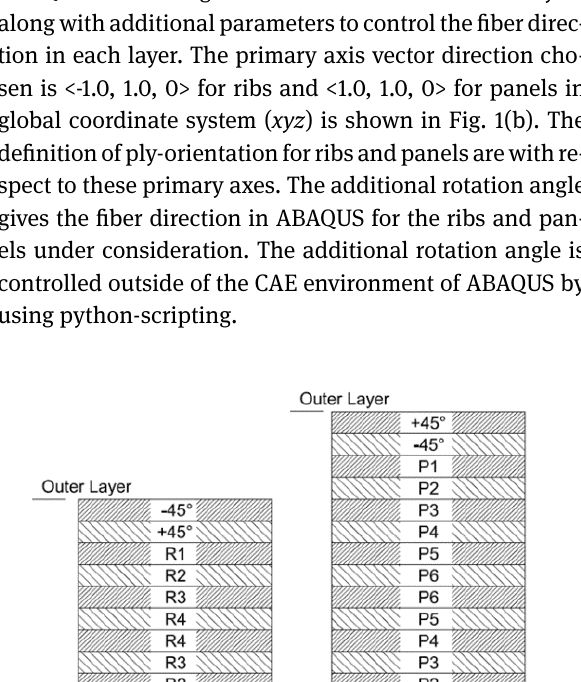
Figure 4: Ply Orientation Parameters for Ribs and Panels